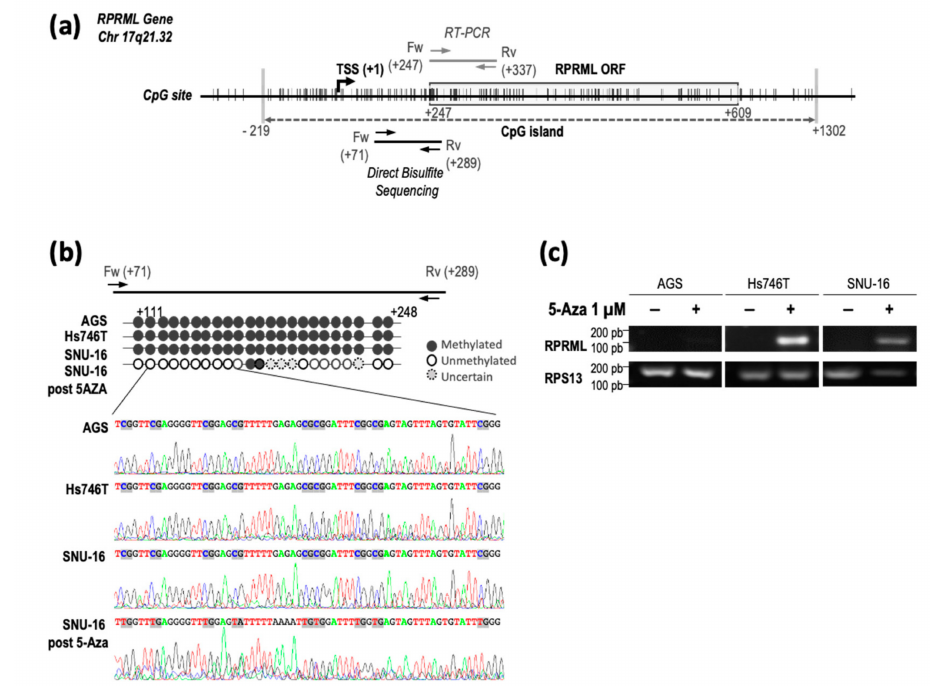
Figure 3. RPRML gene structure, methylation status, and transcript expression in GC cell lines after the 5-azacytidine (5-Aza) assay. ( a ) Schematic representation of RPRML gene structure, open reading frame (ORF), and CpG sites (vertical lines). A dense CpG island is depicted by a gray dashed arrow between nucleotides − 219 and + 1302 relative to the transcription start site (TSS). The region analyzed within the RPRML gene by direct bisulfite sequencing is located between nucleotides + 71 to + 289 relative to the TSS. RT-PCR primers are located between nucleotides + 247 and + 337. ( b ) Schematic representation and electropherograms of direct bisulfite sequencing results in the three GC cell lines. Individual CpG methylation status is represented by black (methylated) and white (unmethylated) circles. The bottom panel shows the result of direct bisulfite sequencing after treatment with 1 µ M 5-Aza. ( c ) Re-expression of RPRML transcripts after treatment with 1 µ M 5-Aza in three endogenously silent GC cell lines (AGS, Hs746T,